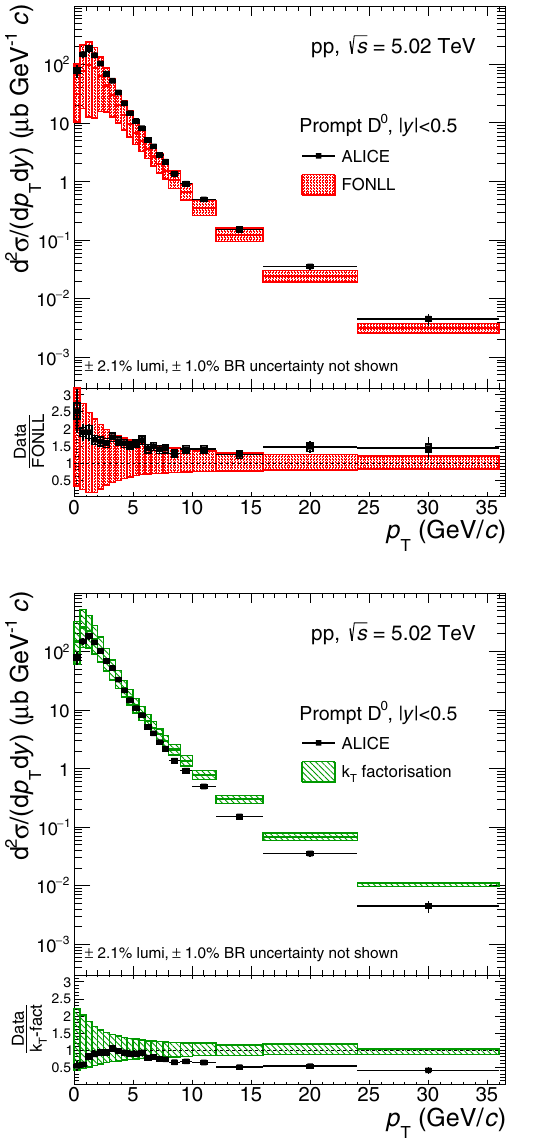
Fig. 8 p T -differential production cross sections for prompt D 0 meson compared to pQCD calculations: FONLL [7,8], GM-VFNS(mod- μ R , F ) [39,40], GM-VFNS(SACOT- m T ) [6], and k T -factorisation [41].